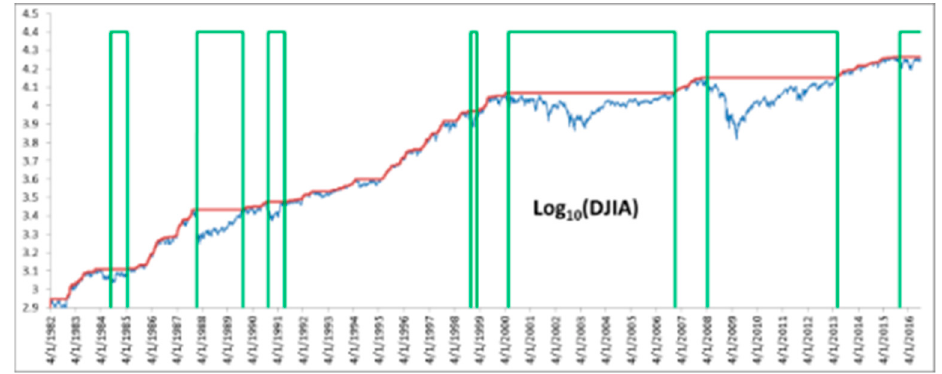
Figure 6. The crisis periods are analyzed on the DJIA chart. Source: Authors’ processing is based on data downloaded from http://stooq.com/site (accessed on 20 July